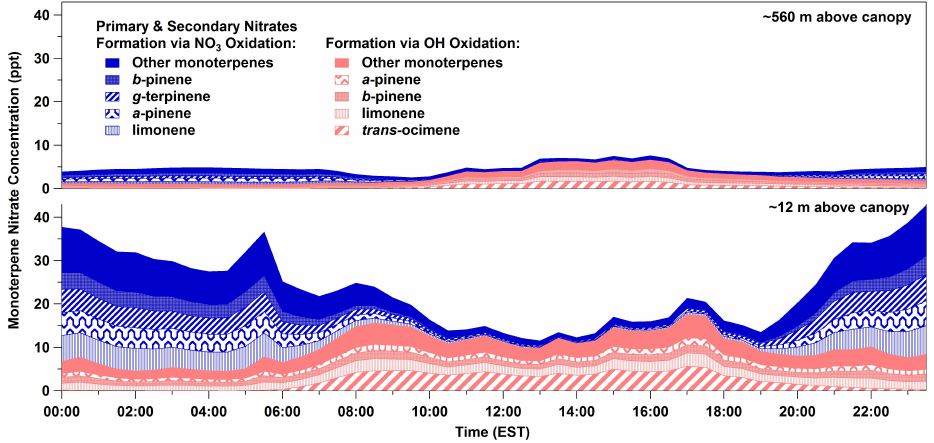
Fig. 9. Diurnal cycles of modeled monoterpene nitrate concentrations at ∼ 560m and ∼ 12m above the forest canopy. Both primary and secondary nitrates are shown, where the oxidant refers to the initial reaction. Results for the maximum BVOC production rate scenario are